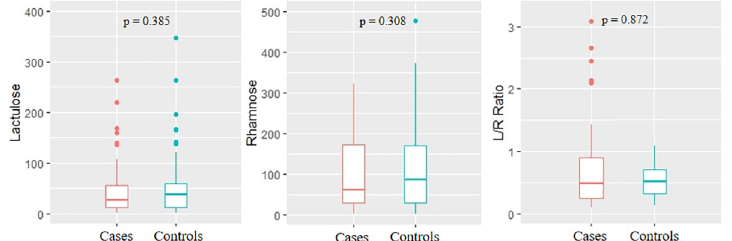
Fig 2. Comparison of urinary excretion of lactulose and rhamnose following oral administration in cases (n = 59) and controls (n = 37). Lactulose and rhamnose are expressed as medians (q1,q3).